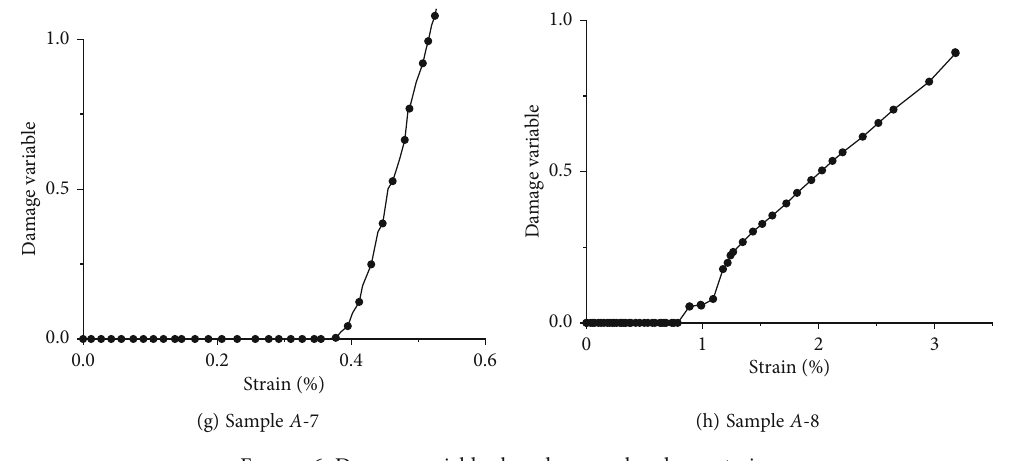
Figure 6: Damage variables based on crack volume strain.